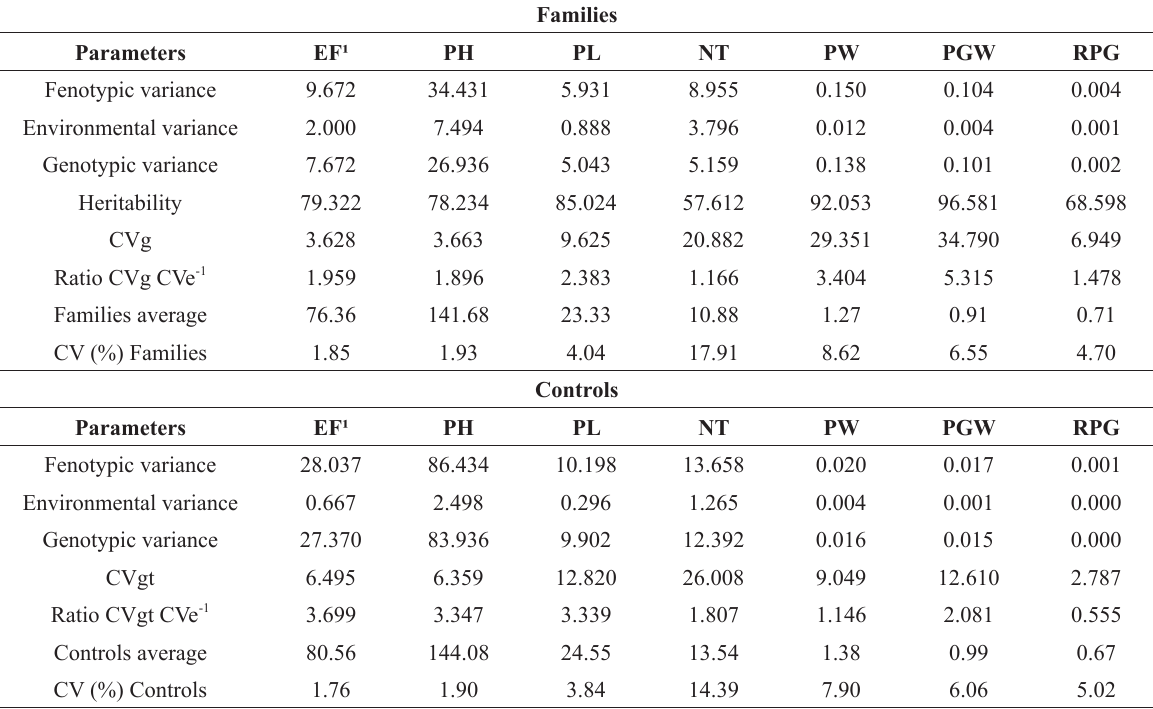
Variance components and genetic parameters estimated for families and controls for 2016 crop season.